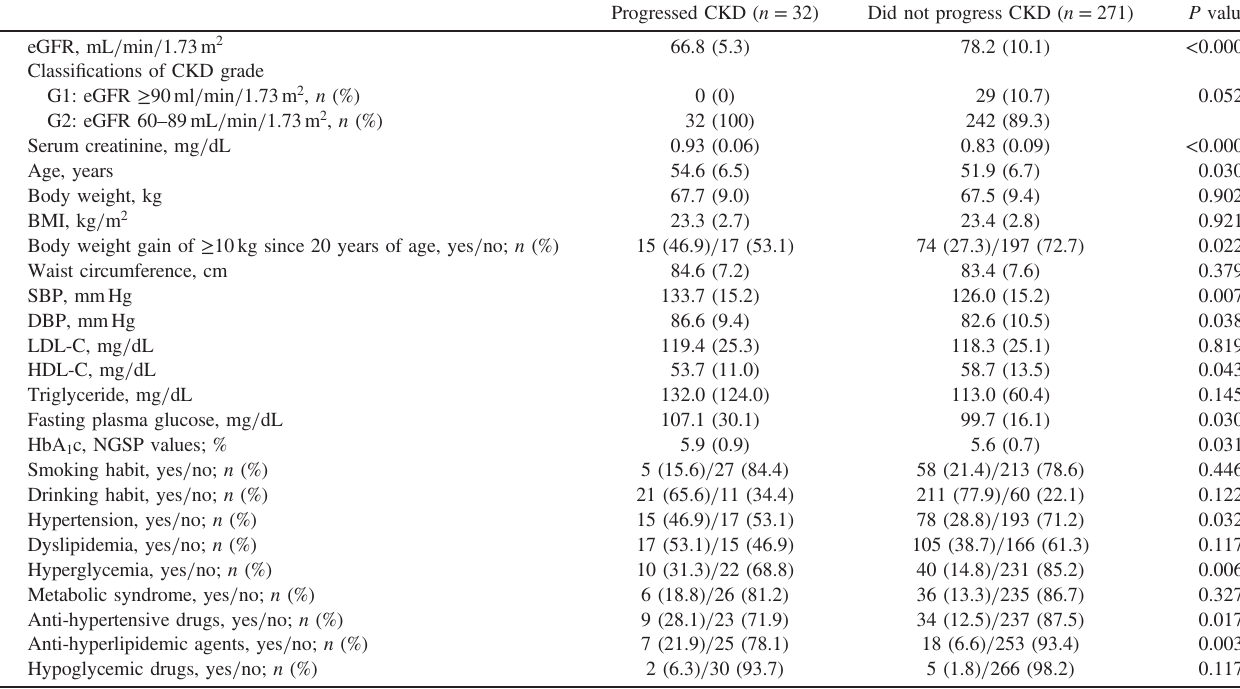
Table 2. The basal characteristics in participants with and without the progression of CKD Progressed CKD ( n = 32) Did not progress CKD ( n = 271) P value eGFR, mL = min = 1.73m 2 66.8 (5.3) 78.2 (10.1) <0.0001 Classi fi cations of CKD